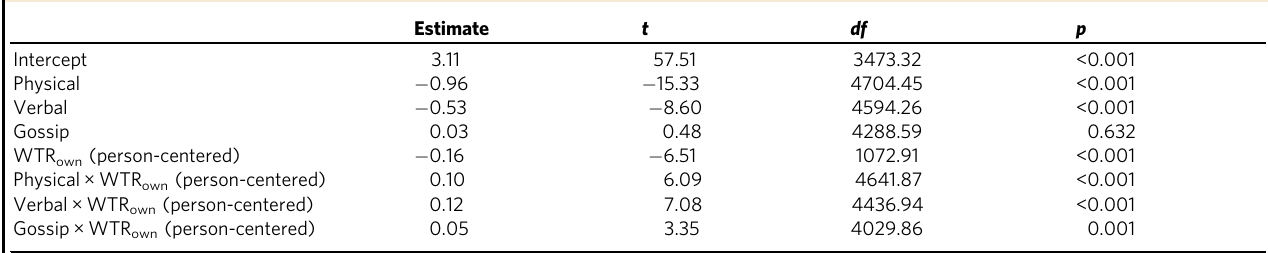
Table 1 Valuation of offenders and endorsement of punishment motivations.